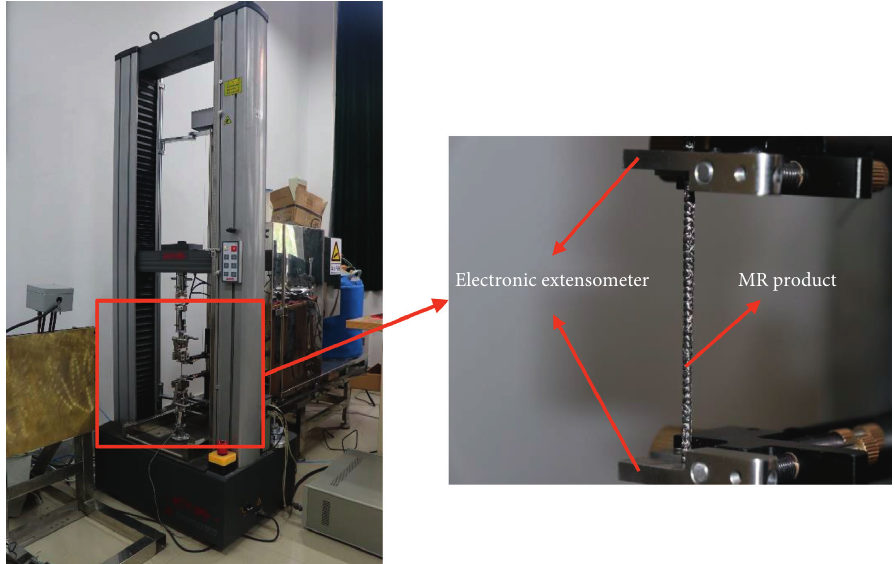
Figure 11: Uniaxial tensile testing fixture.